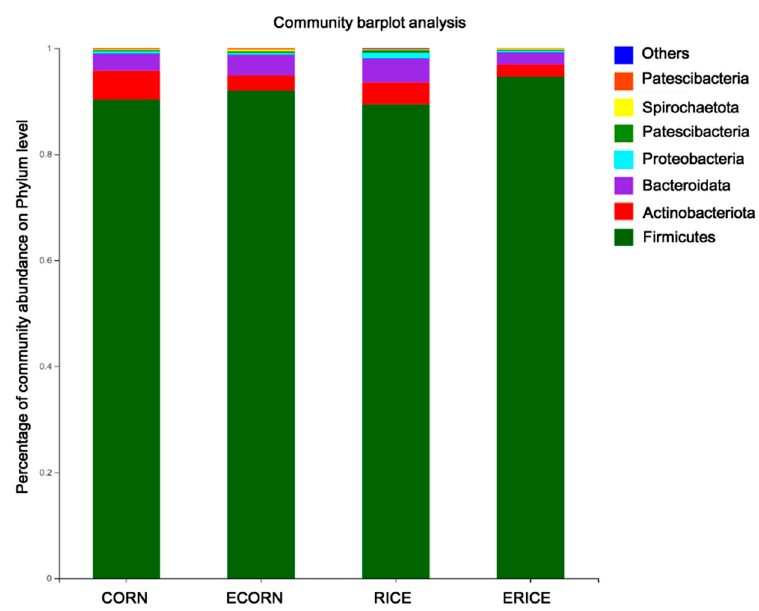
Figure 5. Analysis for differential bacteria at the Phylum level among four dietary treatments.